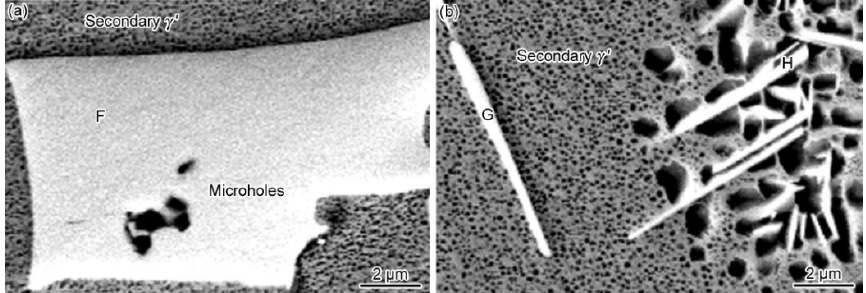
Figure 9. The microstructure of brazing joints after PBHT at 1150 °C/4 h (air cooling) and 870 °C/24 h (air cooling): ( a ) micro-holes in F phase and secondary γ′ precipitates in the central ISZ and ( b ) secondary γ′ precipitates and G phase at the edge of the ISZ and H phase in the DAZ.